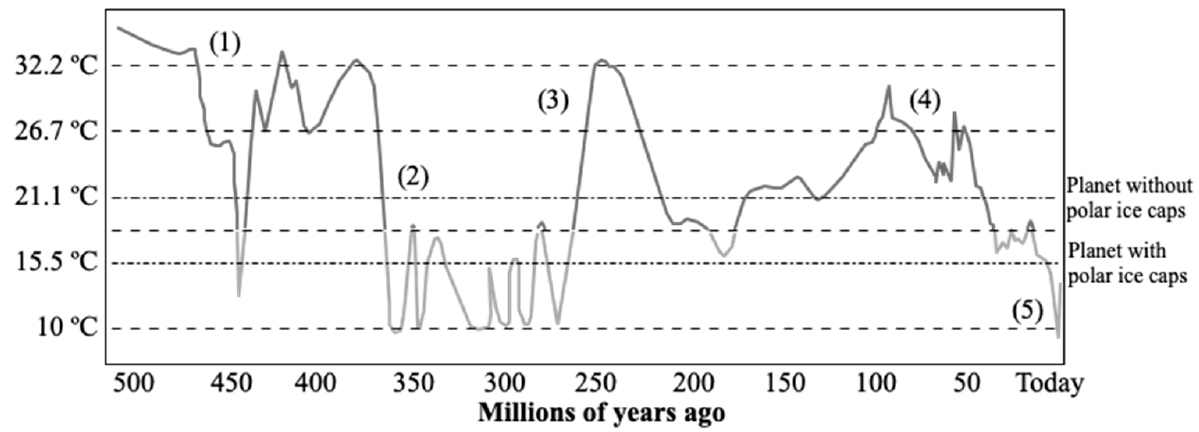
Figure 2. Preliminary results from a Smithsonian Institution project led by Scott Wing and Paul Huber, showing the earth’s average surface temperature over the past 500 million years. For most of the time, global temperatures appear to have been too warm (red portions of line) for persistent polar ice caps. The most recent 50 million years are an exception. (1) Marine life diversified in extreme heat; (2) Period before land-based plants absorbed CO 2 and polar ice caps formed; (3) Volcanic activity oscillated CO 2 levels; (4) Mammals evolved in a warmer period; and (5) Humans are warming the climate (adapted from https://www.climate.gov/media/11332, accessed on 20 November 2021).